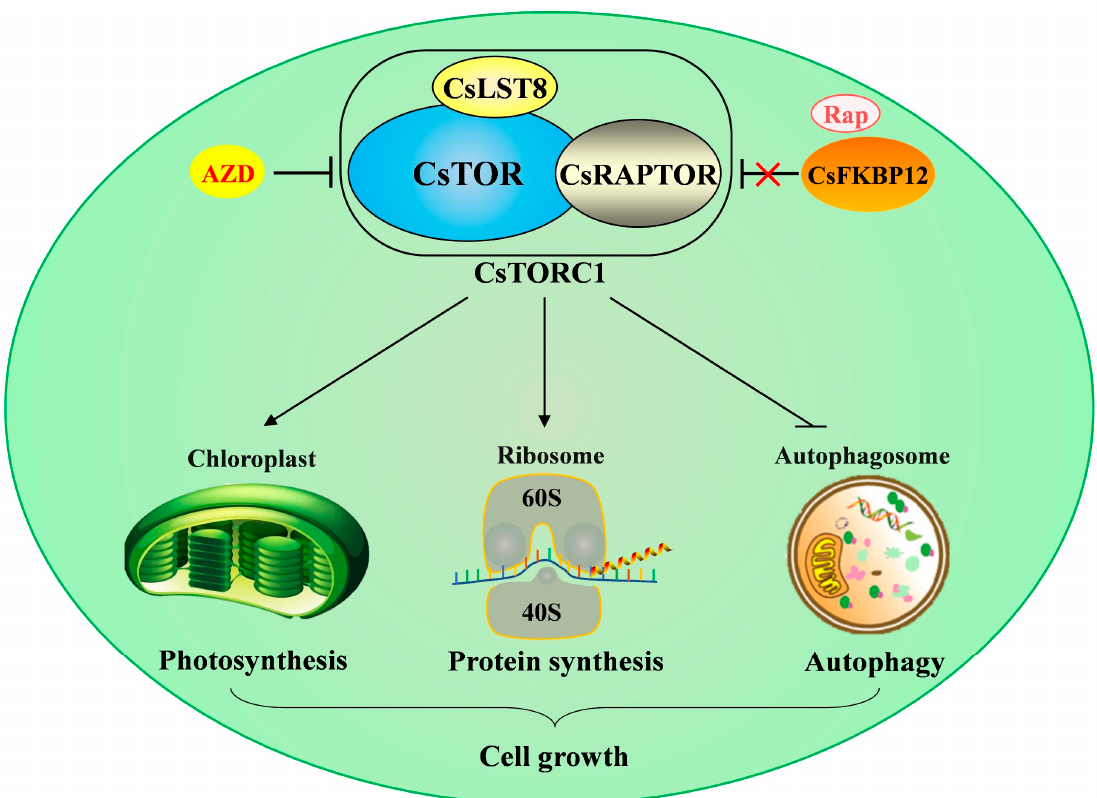
Figure 8. The graphic illustration of CsTOR signaling regulating cell growth in Chlorella sorokiniana . Arrows and T-bars represent enhancement and inhibition, respectively. AZD, AZD8055; Rap, rapamycin.